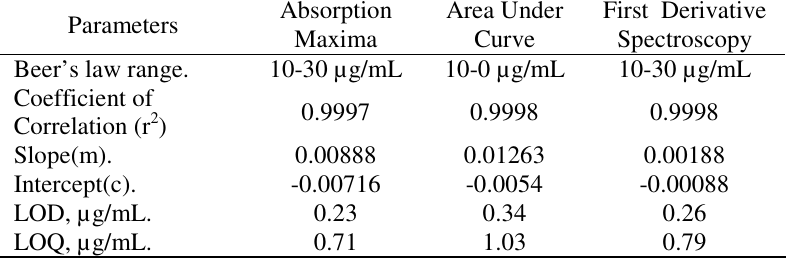
Table 1. Statistical parameters of linearity of nabumetone Absorption Area Under First Derivative Parameters Curve